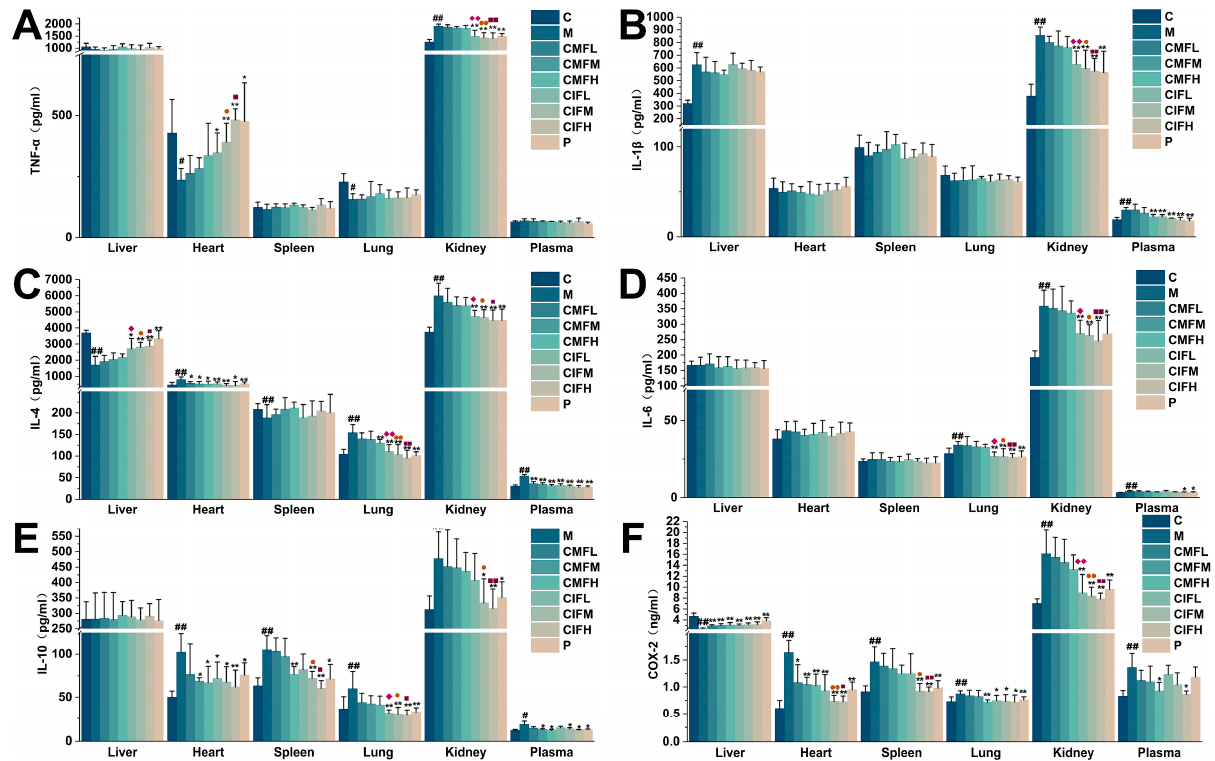
Figure 6. Activity assay of inflammatory mediators. ( A – F )—Determined results of TNF- α , IL-1 β , IL-4, IL-6, IL-10 and COX-2 in plasma, and tissues samples of liver, heart, spleen, lung and kidney. Values shown are means ± SD. # p < 0.05, ## p < 0.01 compared with C group; * p < 0.05, ** p < 0.01 compared with M group; ◆ p < 0.05, ◆◆ p < 0.01 compared with CMFL group; ● p < 0.05, ●● p < 0.01 compared with CMFM group; ■ p < 0.05, ■■ p < 0.01 compared with CMFH group.